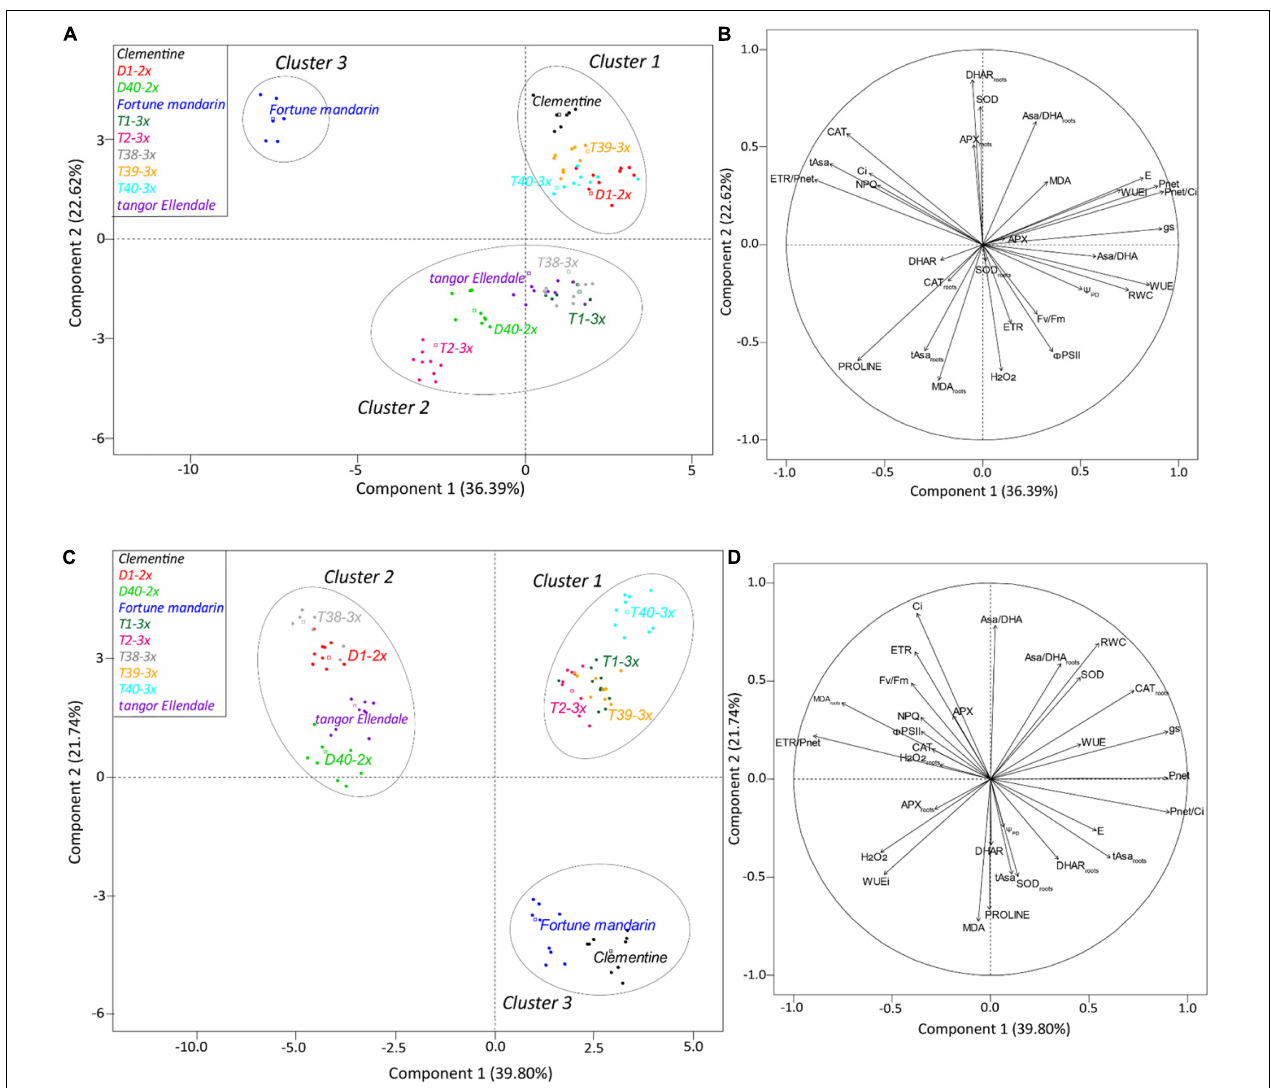
FIGURE 7 | Biplot obtained from PCA performed on leaves of studied citrus varieties under water deficit (A,B) and after the recovery period (C,D) . Panels (A–C) repartition of varieties on the two first axes and (B–D) contribution of each physiological and biochemical variable to the two first axes of